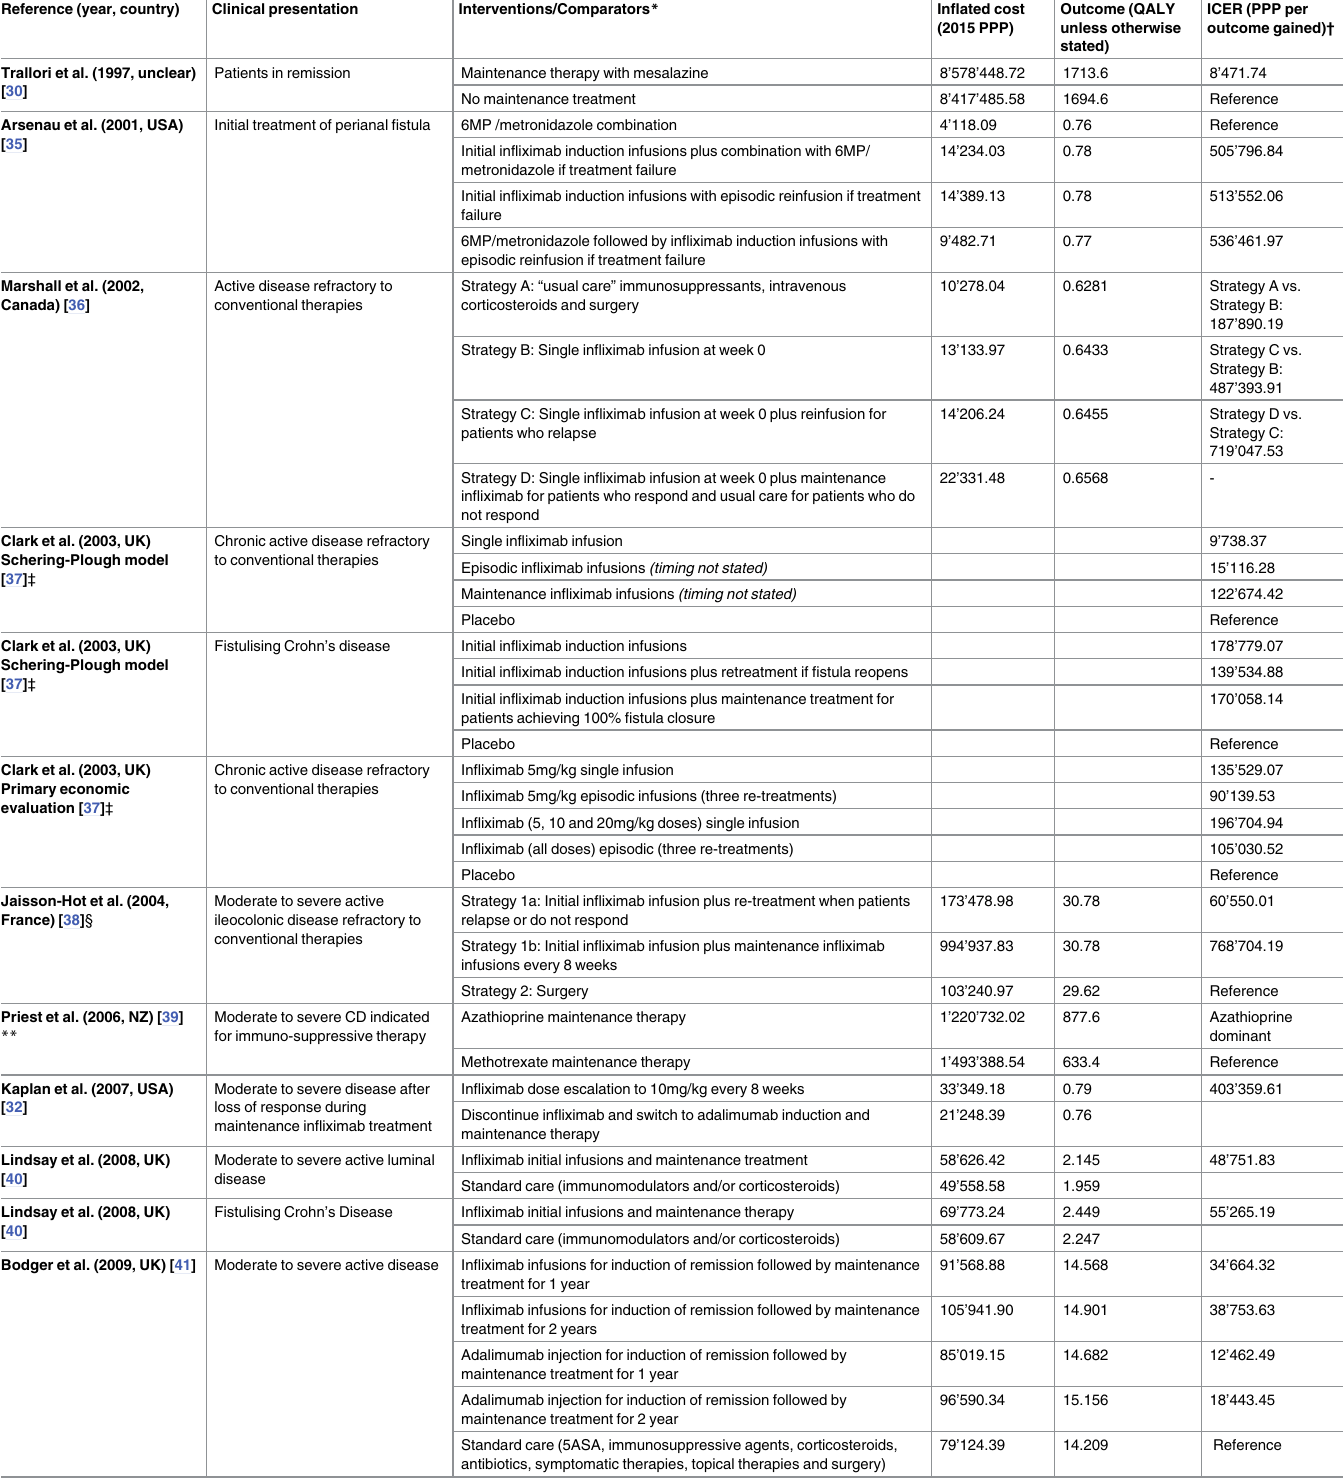
Table 2. Summaryof cost-effectivenessresults adjusted to 2015 PPP for studies on Crohn’s disease.